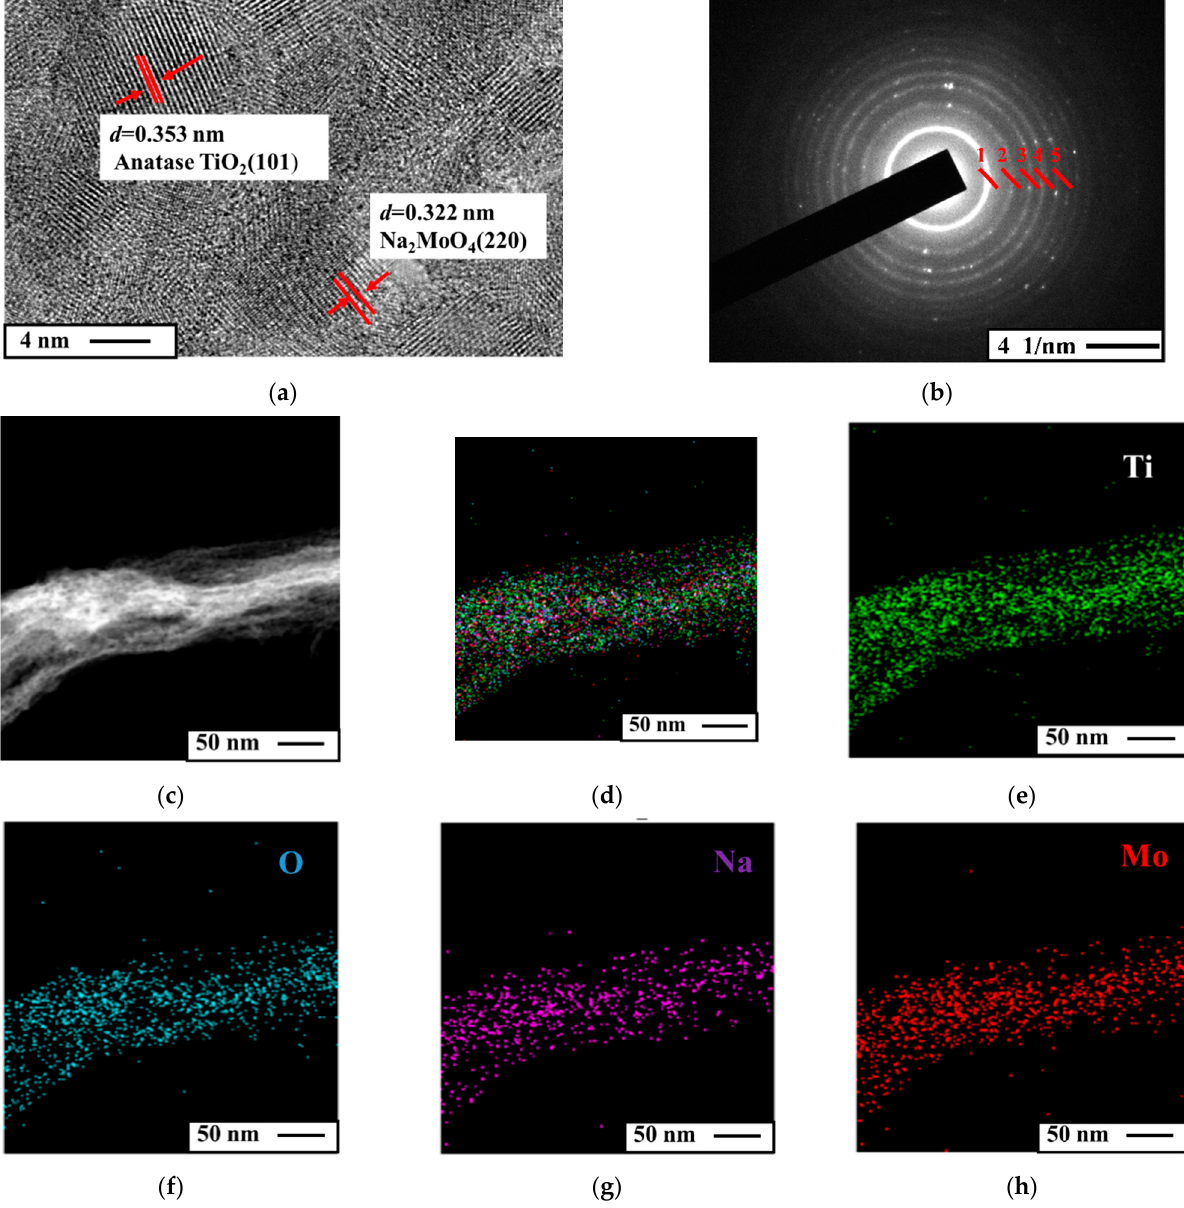
Figure 4. ( a ) HR-TEM image of the nanocomposite tube surface, ( b ) the corresponding SAED pattern, and ( c – h ) the EDS elemental mapping of an individual composite nanotube of the nanotubular Na 2 MoO 4 – 41.4%-TiO 2 composite.